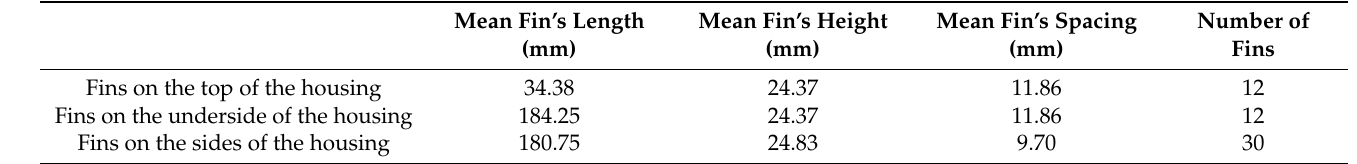
Table 1. Characteristic data of the fin section.